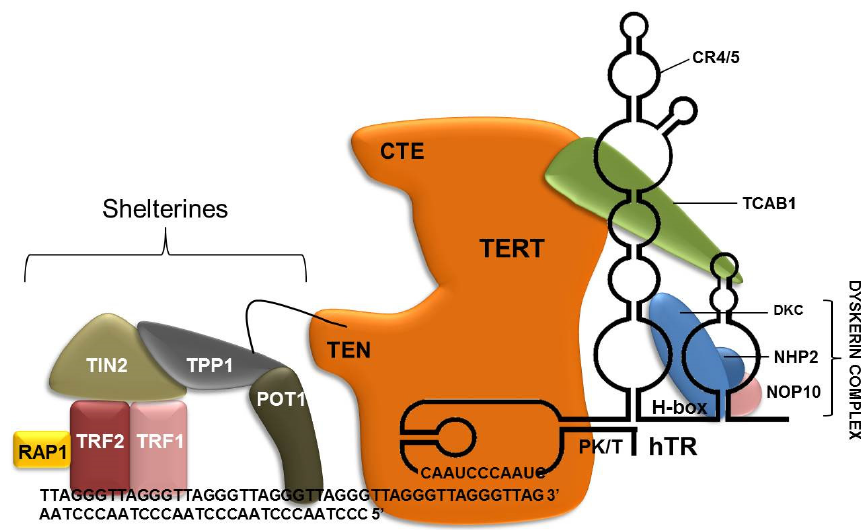
Figure 1. Telomerase representation. Dyskerin complex (NHP2, NOP10 and DKC) binds to hTR through its ACA domain. TCAB1 binds to TERT and to hTR. The template region of hTR binds to the telomeric 3 (cid:48) -end strand. Shelterin binds to telomeric repeat region. TRF2 interacts with RAP1 and TRF1, binding directly to the telomeric DNA and to TIN2, which also binds to TPP1. TPP1 interacts with POT1, which is responsible for recruiting telomerase to telomeres through the TEN domain of